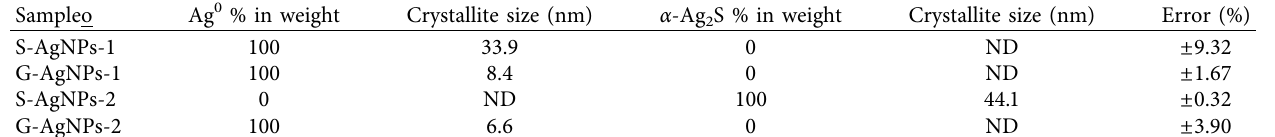
Table 2: Rietveld refinement of the silver nanomaterials before and after corrosion process.